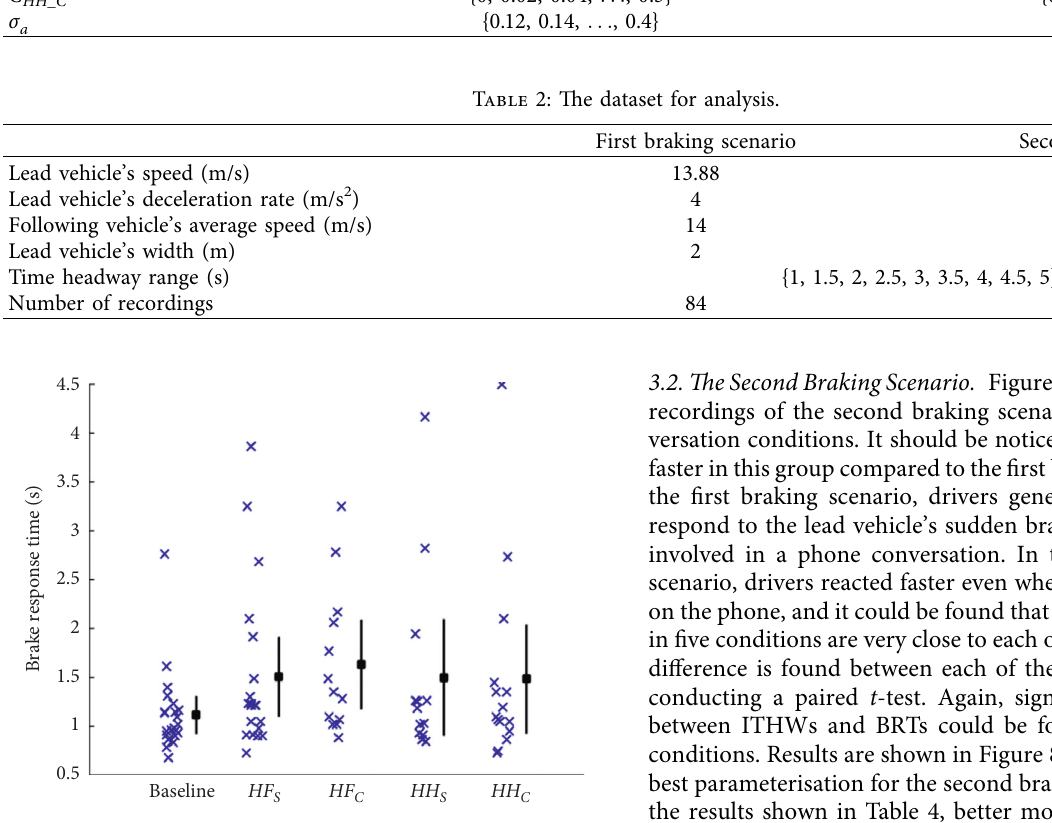
Figure 3: Drivers’ brake responses to the first braking scenario under five conditions (black square and whisker indicate the mean value and standard deviation on 95% CI,